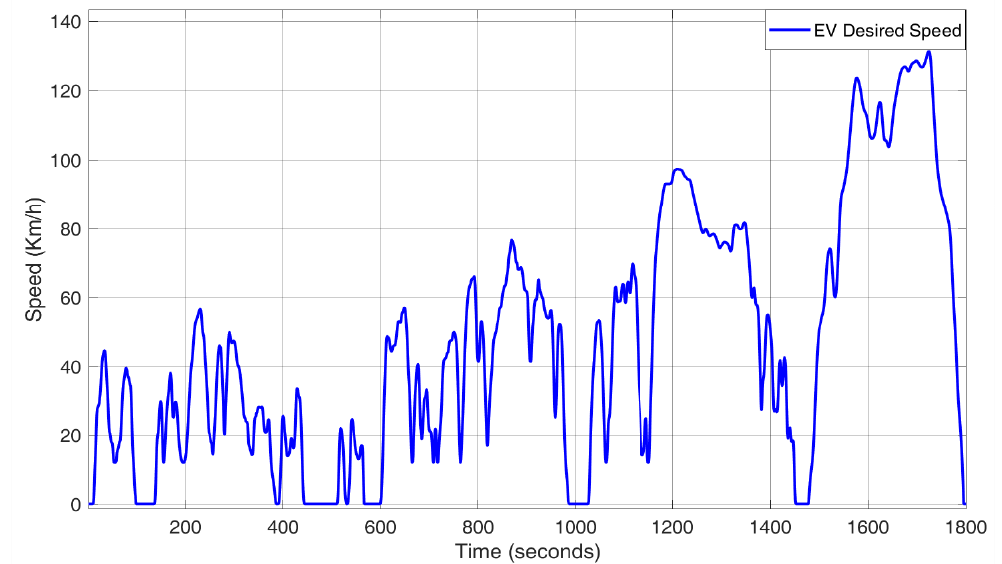
Figure 6. WLTP class 3 driving cycle used as input to the electrified